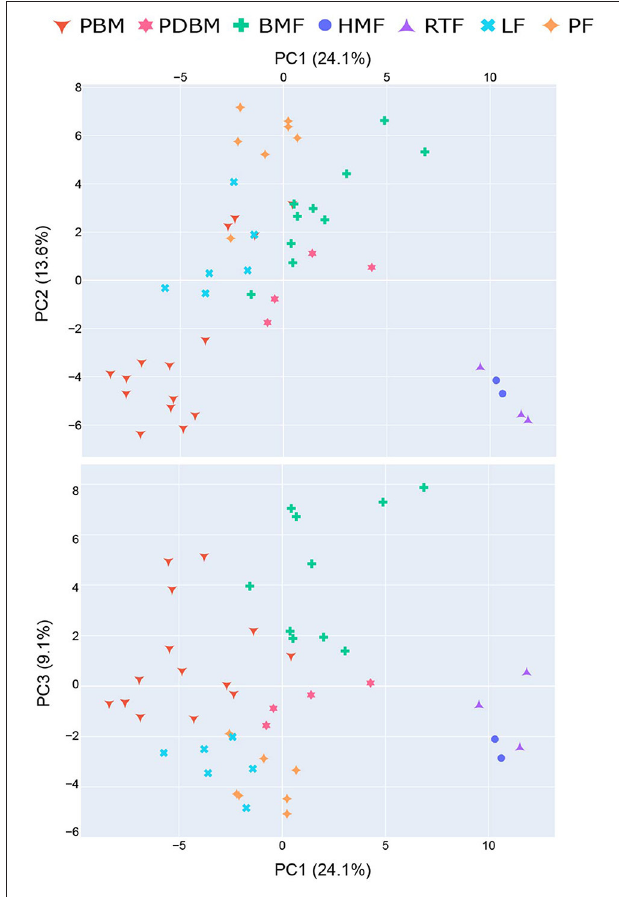
FIGURE 2 | Principal Component Analysis (PCA) explained 47% of variability of different milk types in the first three components. HMF, Human-milk based fortified breastmilk; PBM, Preterm breastmilk; BMF, Bovine milk-based fortified breastmilk; RTF, Human milk-based Ready-To-Feed formula; PF, Powder Formula; LF, Liquid Formula; PDBM, Pasteurized Donor